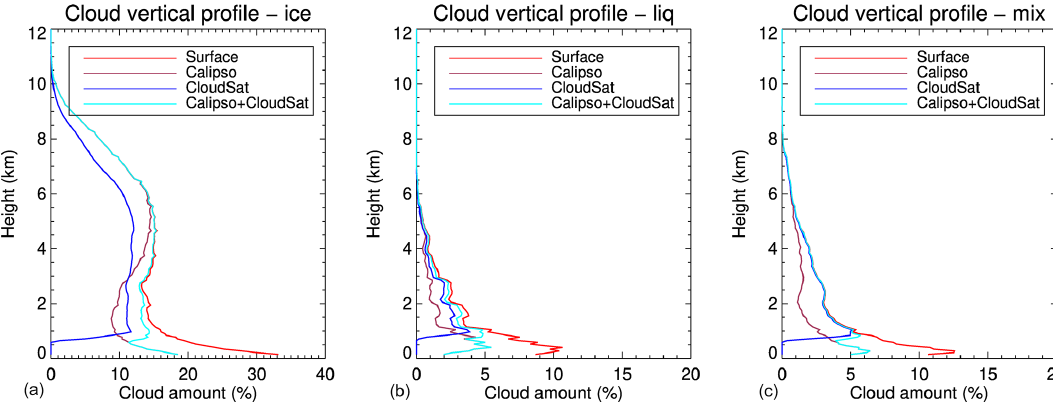
Figure 8. Mean cloud amount vertical distributions from surface observations and from simulated CloudSat, CALIPSO, and combined CloudSat and CALIPSO for (a) ice, (b) liquid, and (c) mixed-phase clouds during the SHEBA